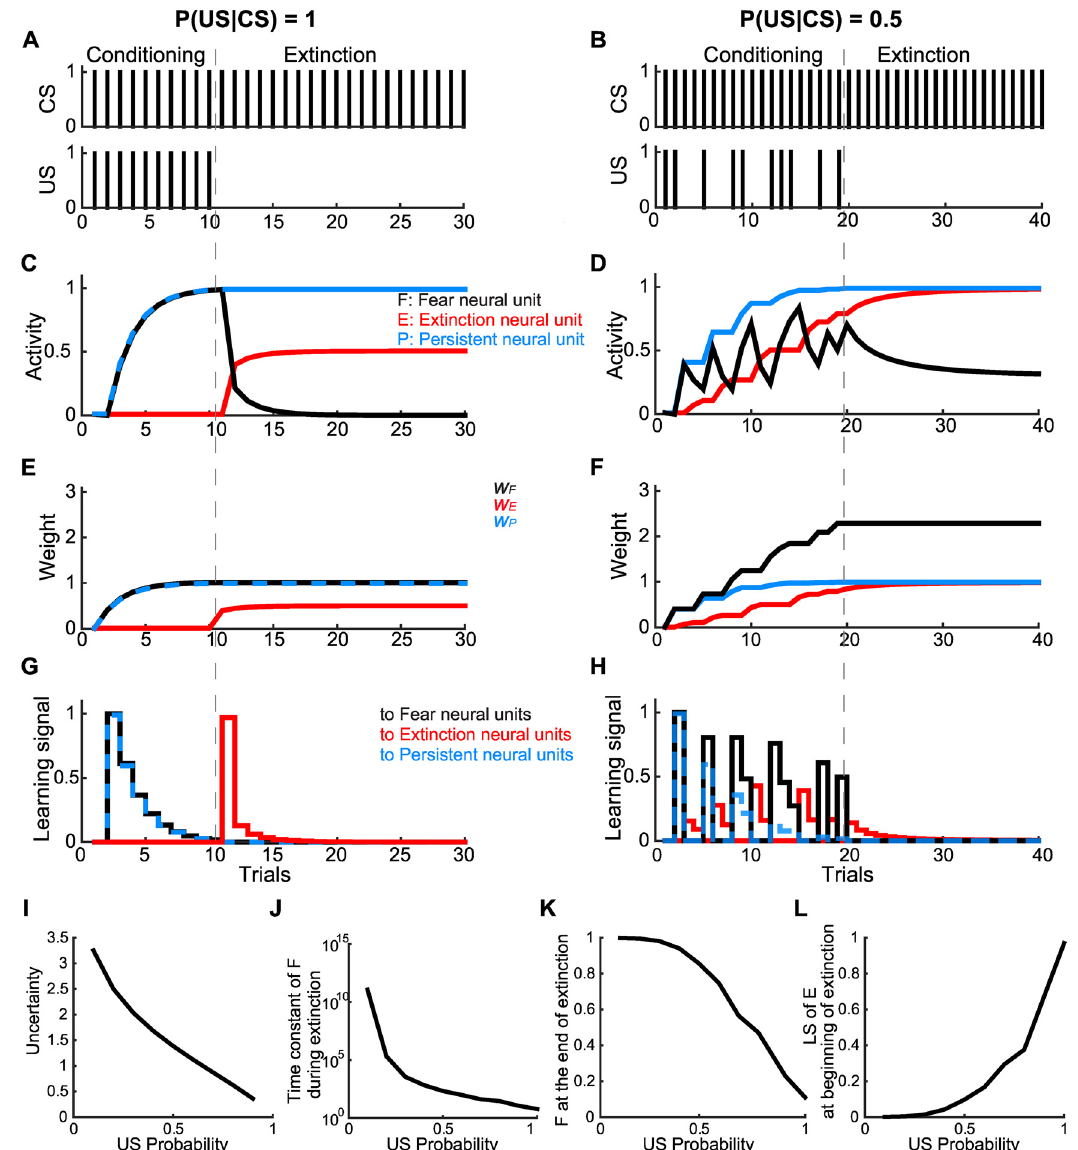
Fig 2. Fear memory acquired during the full and partial reinforcement schedules in the basic model. Basic model simulation results for the full and partial reinforcement schedules are presented in the left (A, C, E and G) and right (B, D, F and H) columns, respectively. (A, B) CS and US schedules during fear conditioning and extinction. (C, D) The black, blue and red lines indicate the activity of the fear, persistent and extinction neural units, respectively. (E, F) The black, blue and red lines indicate the synaptic weights of the CS-related inputs to the fear, persistent and extinction neural units, respectively. (G, H) The black, blue and red lines indicate the learning signals that changed the weights of CS-related synaptic inputs to the fear, persistent and extinction neural units, respectively. Note that overlapping lines were changed to dashed lines to make them visible. (I-L) The uncertainty of the next US observation (I) , the time constant of fear memory decline (J) , the relative fear-related neural activity at the conclusion of extinction (K) and the learning signal received by the extinction neural unit at the beginning of extinction (L) vary with the probability of the US. The time constant (J) was evaluated by fitting time course of the fear neural unit activity during extinction with F = F 1 exp( -t/ τ )+ F 0 , where F 0 and F 1 indicate positive constants, and t and τ indicate the number of extinction trials and the time constant, respectively.